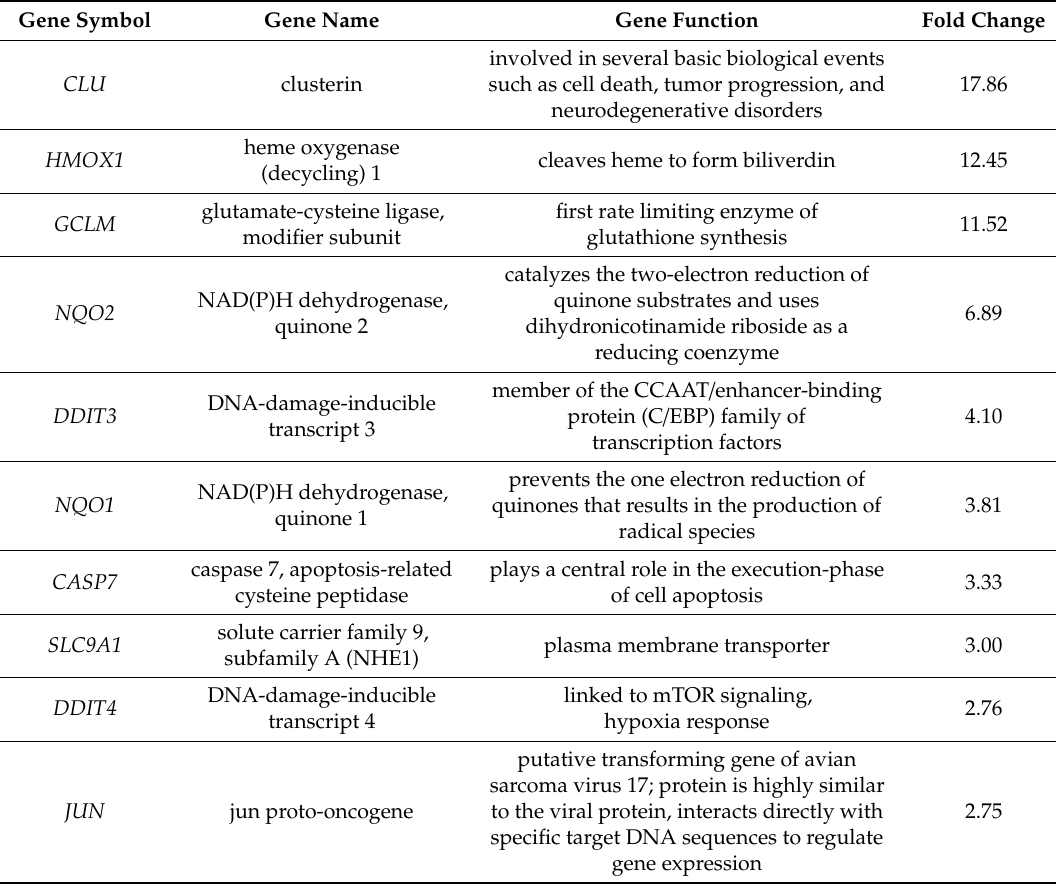
Table 3. The list of 10 most upregulated genes involved in neuron death process in bortezomib-treated SH-SY5Y cells compared to controls. Gene function according to NCBI Gene